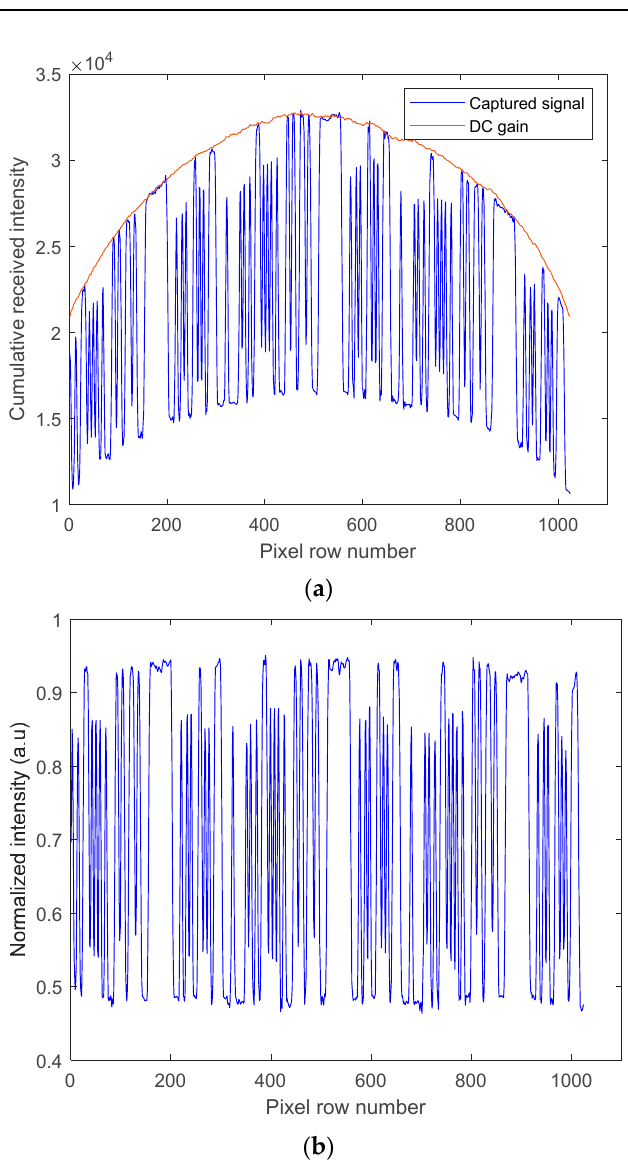
Figure 4. An example of a captured image frame for the camera-based Rx: ( a ) before and ( b ) after intensity normalization.